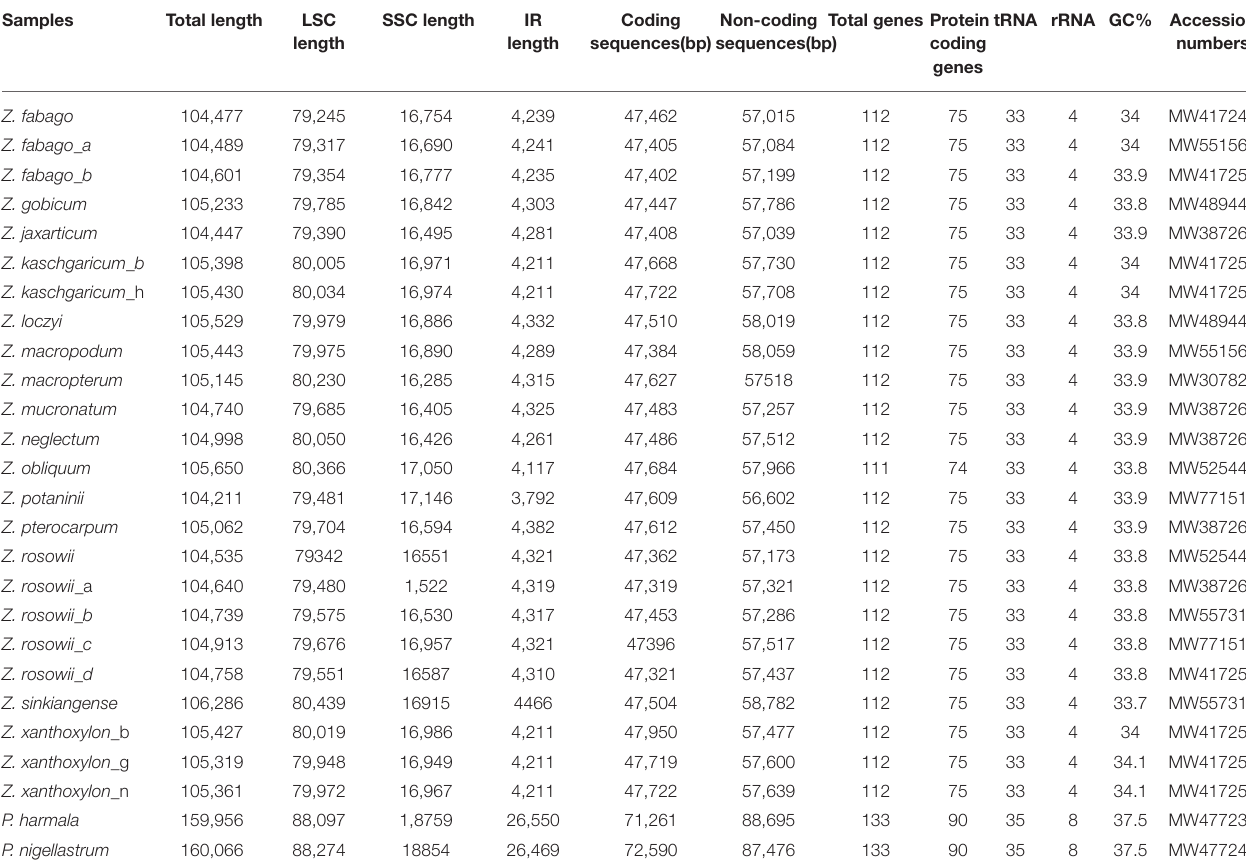
TABLE 2 | Summary statistics for complete chloroplast genomes of the sampled accessions of Zygophyllum and Peganum .